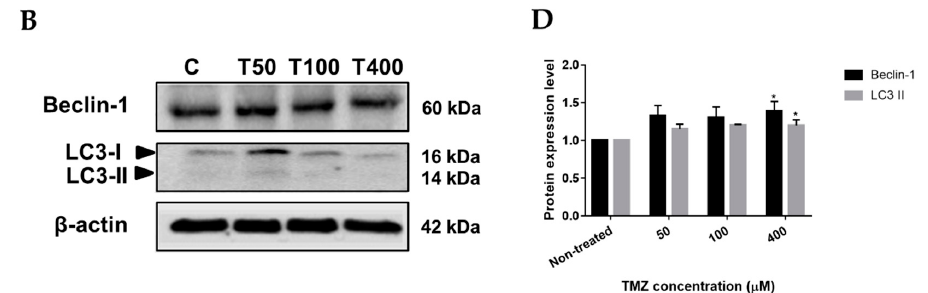
Figure 4. Neferine triggers autophagy in human neuroblastoma cells. (A,B) IMR32 cells were exposed to the indicated concentrations of neferine (A) or TMZ (B) for 24 h. Then, autophagy ‐ related proteins, including Beclin ‐ 1 and LC3, were assessed using Western blot analysis. (C,D) Changes in the levels of Beclin ‐ 1, LC3 ‐ I, and LC3 ‐ II after being normalized to the levels of beta actin were shown. The data are expressed as mean ± SD in three independent experiments. * p < 0.05, ** p < 0.01, *** p < 0.001 as compared with the non ‐ treated control.